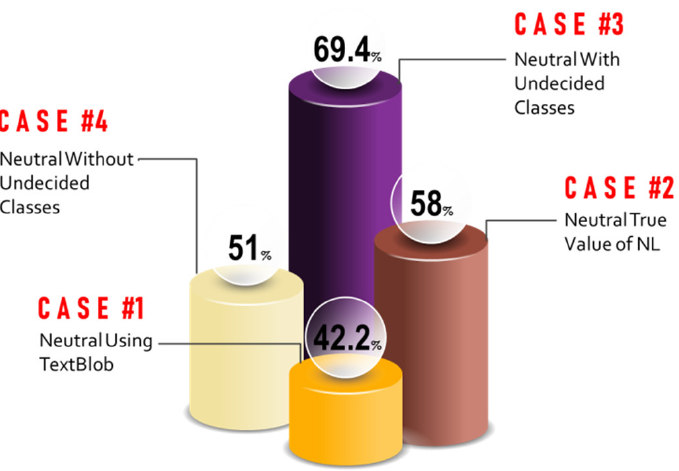
Figure 11. Neutral class change cases.